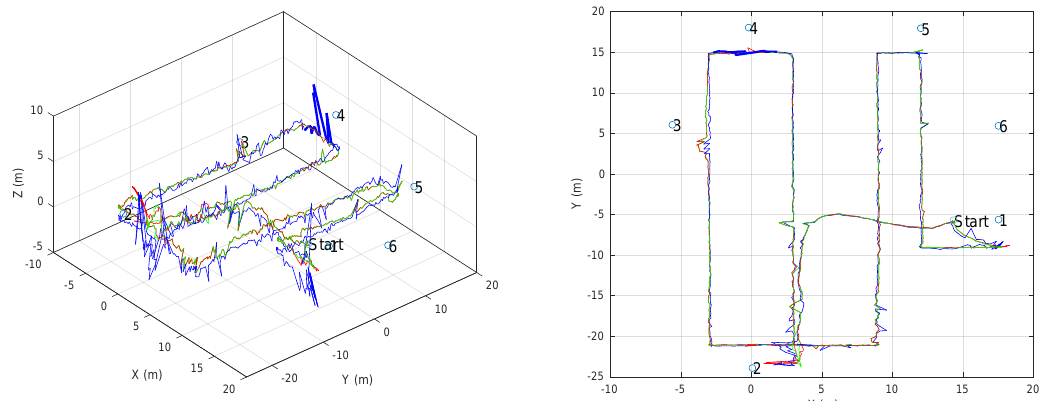
Figure 5. Trace of test measurement (left in 3D, right is top view): blue line is the original trace as computed by the original manufacturer’s software; red trace is the proposed solution, with initial, non-calibrated statistics ( first-run ); green trace is the proposed solution, using the calibrated statistic at the end of the previous lap ( second-run ). Anchors’ positions are represented by circles, marked with numbers